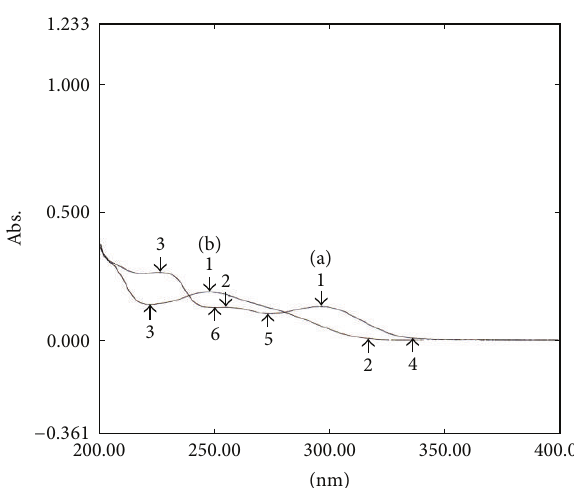
Figure 2: Typical overlaid UV spectra of (a) TLM and (b) ATV.